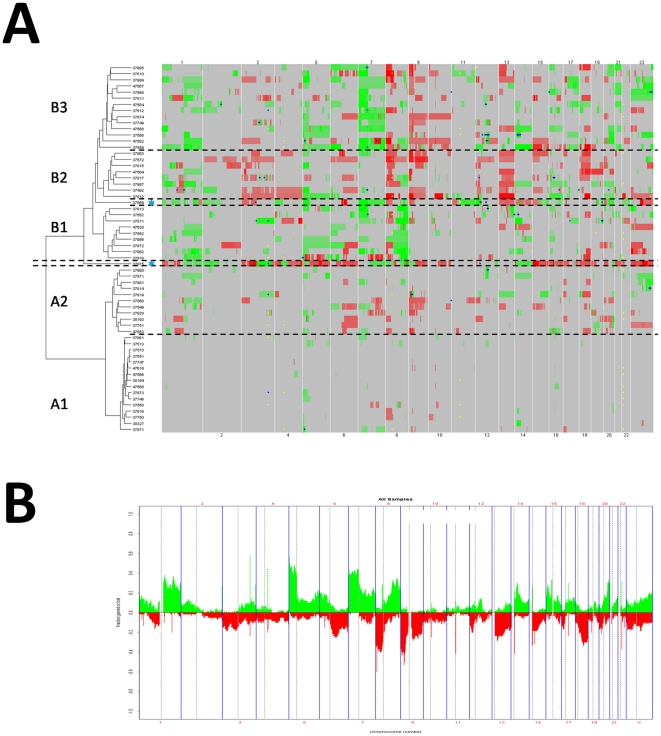
Aberrations using aCGH analysis in 60 never smokers with lung adenocarcinoma.
Panel A. Heat map of gains (green color) and losses (red color) by chromosome generated by non supervised hierarchical clustering. Small blue or yellow dot indicate gains with log2(ratio)>1.5 and losses with log2(ratio)<−1.5, respectively. Blue star (*): two outliers (37875 between classes A and B and 37569 between clusters B1 and B2). Panel B. Distribution of gains (green color) and losses (red color) along the genome.